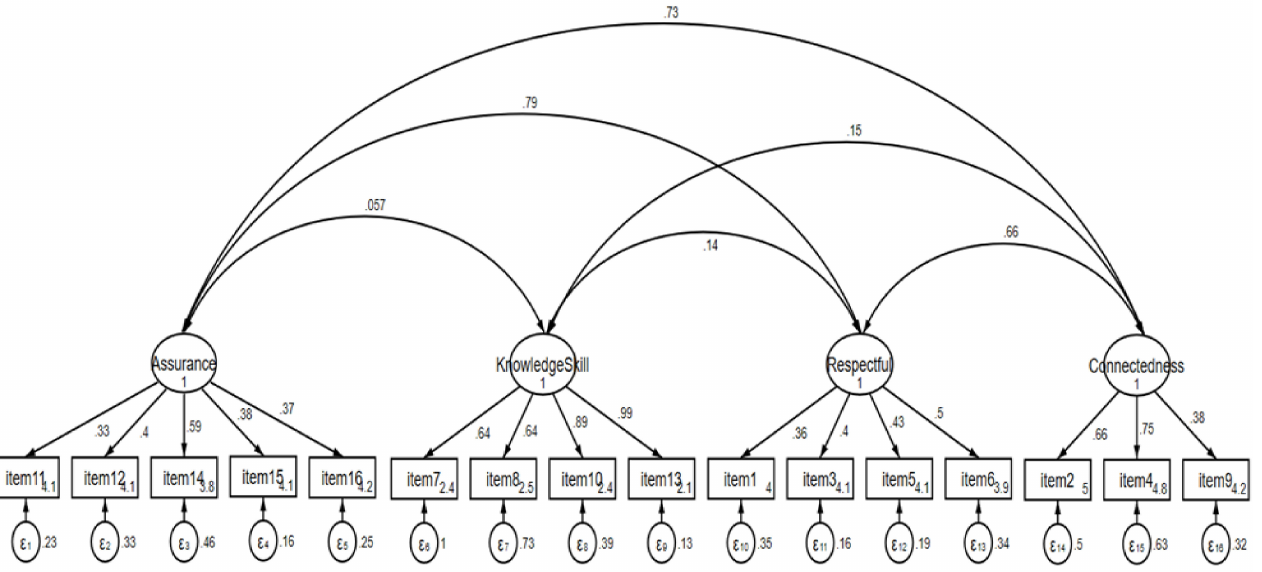
Figure 2. Confirmatory Factor Analysis Model Standardized Coefficients of the Caring Behaviors